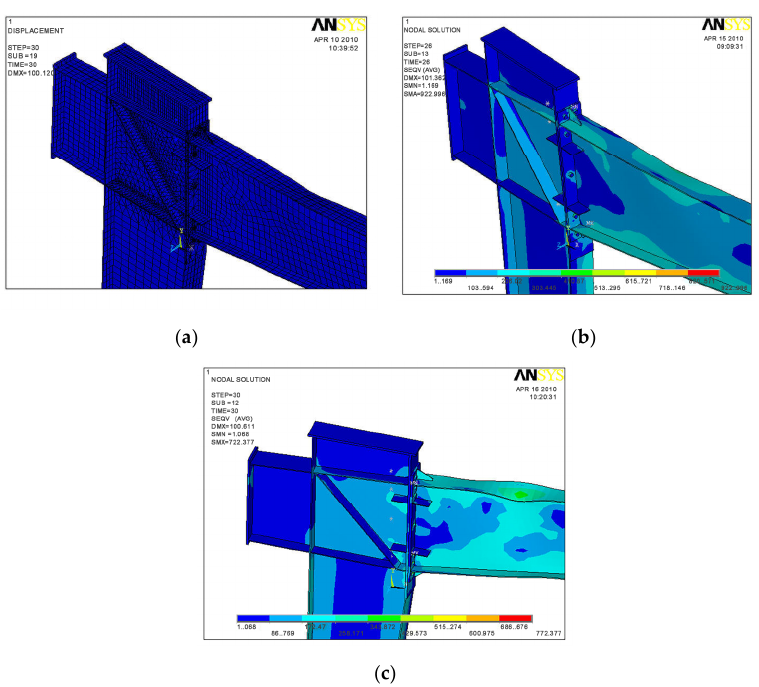
Figure 16. FEA model failure mode. ( a ) SV1; ( b ) SV2; ( c ) SV3.